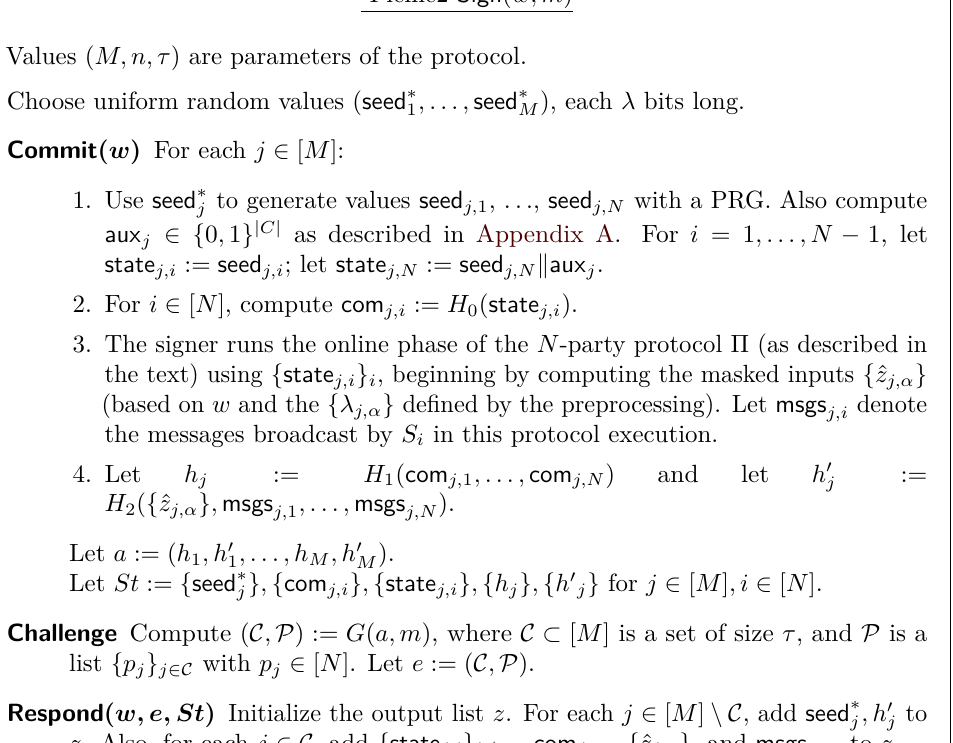
Figure 1: The signing algorithm in the Picnic2 signature scheme.